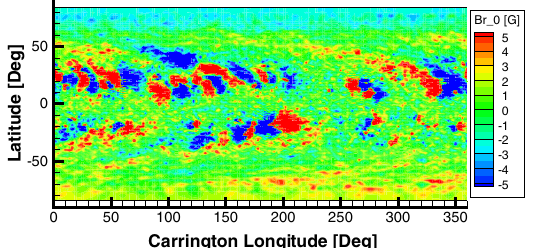
Fig. 17 Carrington map of the radial magnetic field component at 1 R (cid:5) . This map is based on a synoptic magnetogram of Carrington rotation 2109 (2011 April 12 to May 9) from GONG and processed to a PFSS solution using spherical harmonics. For the purpose of showing both the coronal holes and active regions, the magnetic field in this plot is saturated by ± 5